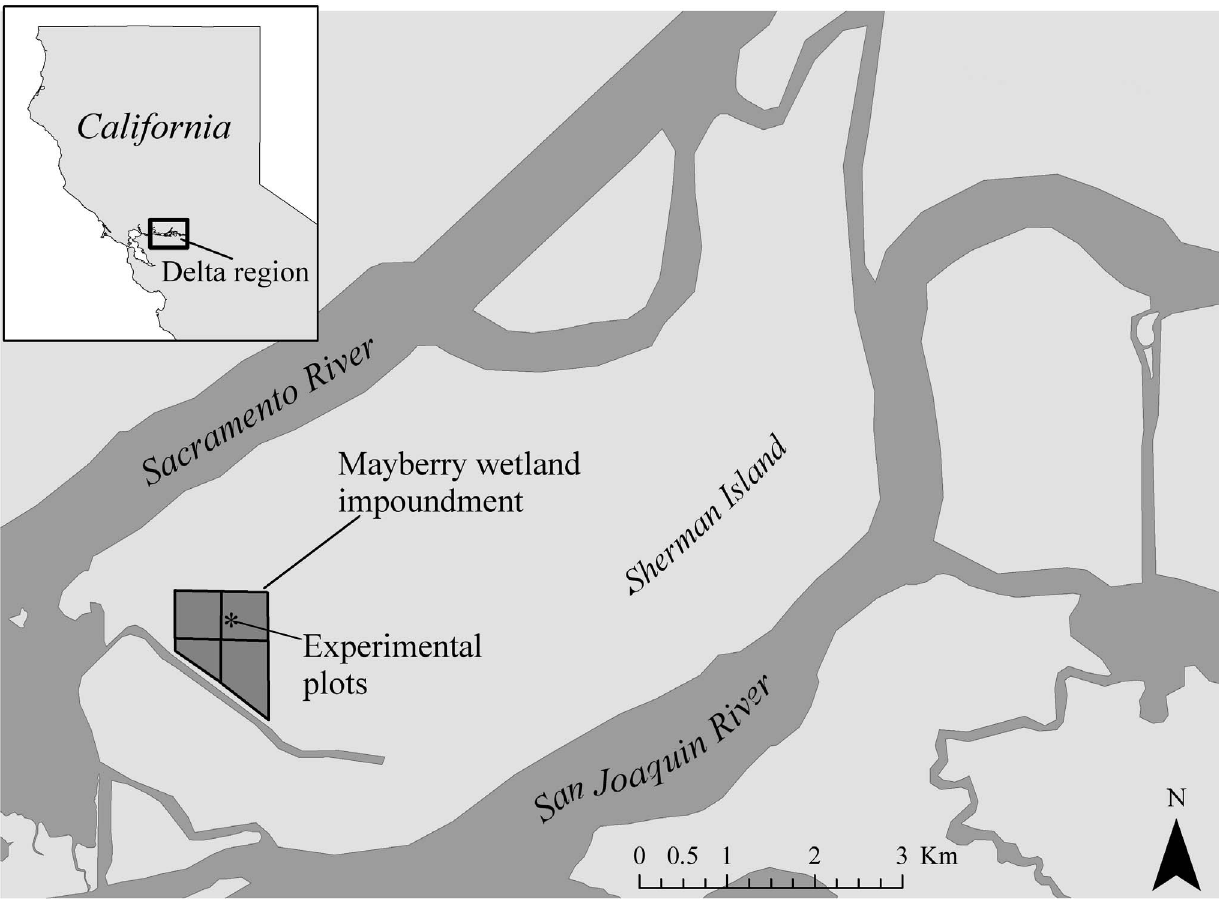
Figure 1. Study site. The Sacramento-San Joaquin River confluence and associated Delta within California’s Central Valley, USA. Locations of the Mayberry wetland impoundment and experimental site are indicated.